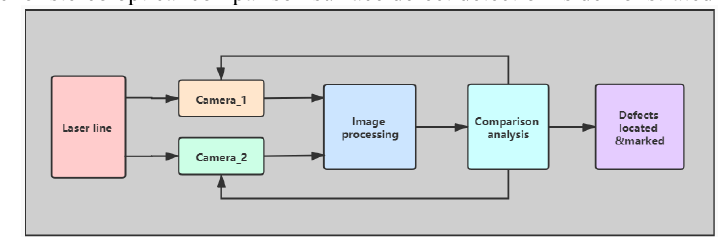
Fig. 2. Stereo optical comparison model of process of each defect detection.